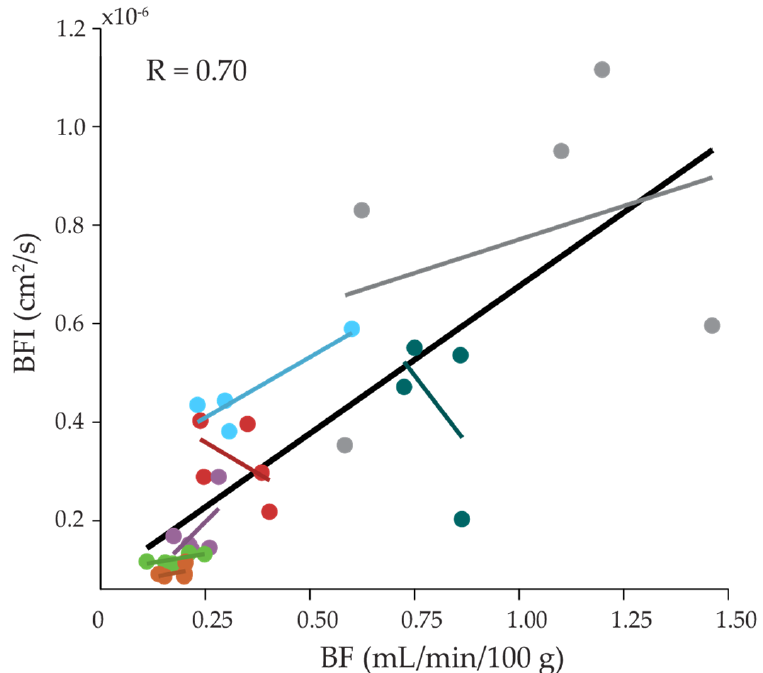
Figure 1. Relationship between NIRS and DCS measured blood flow. Blood flow measured during venous occlusion with NIRS (BF) at 3.5 cm versus blood flow index measured by DCS averaged 15 s prior to venous occlusion (BFI). Data are color-coded by participant. The solid black line and indicates the overall linear fit for the group data. Colored lines indicate best linear fits for individual participants.